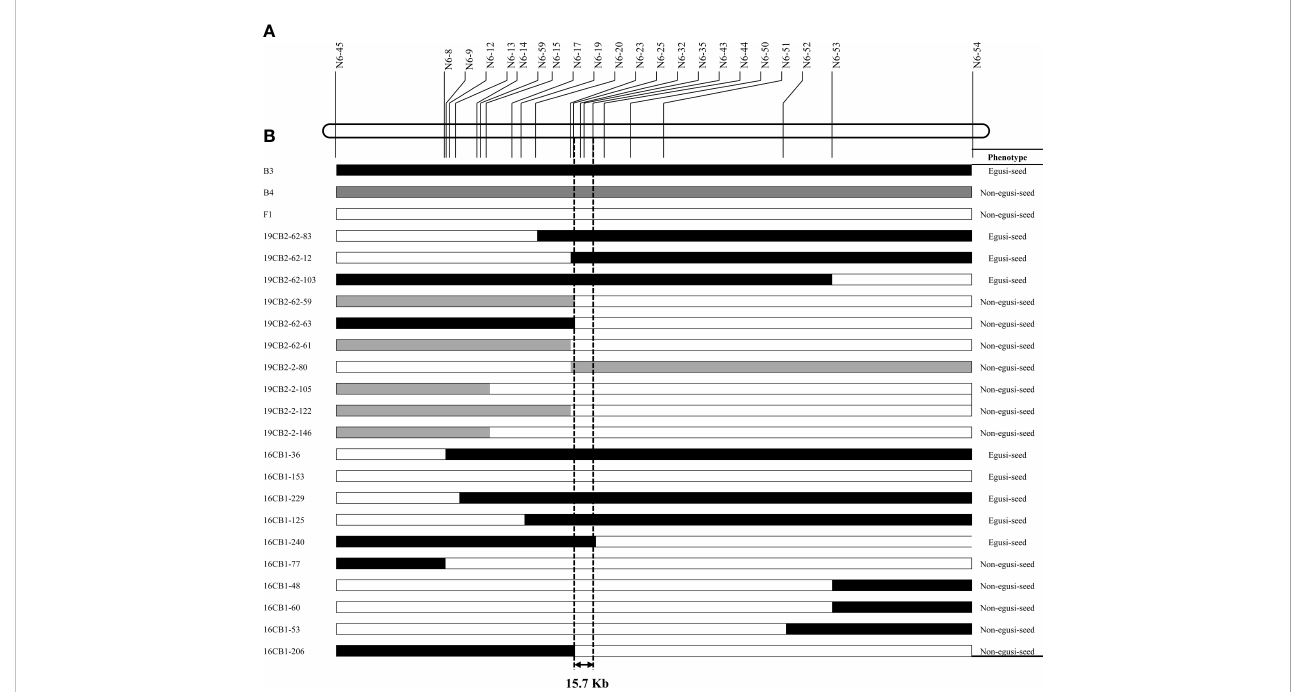
FIGURE 5 Graphical genotype of the recombinants and their seed type in the 19CB2 and 16CB1 populations. (A) Partial physical map of the genomic region of eg on chromosome 6. (B) eg was narrowed to a 15.7-kb region between N6-25 and N6-43 by analyzing the genotypes and phenotypes of these